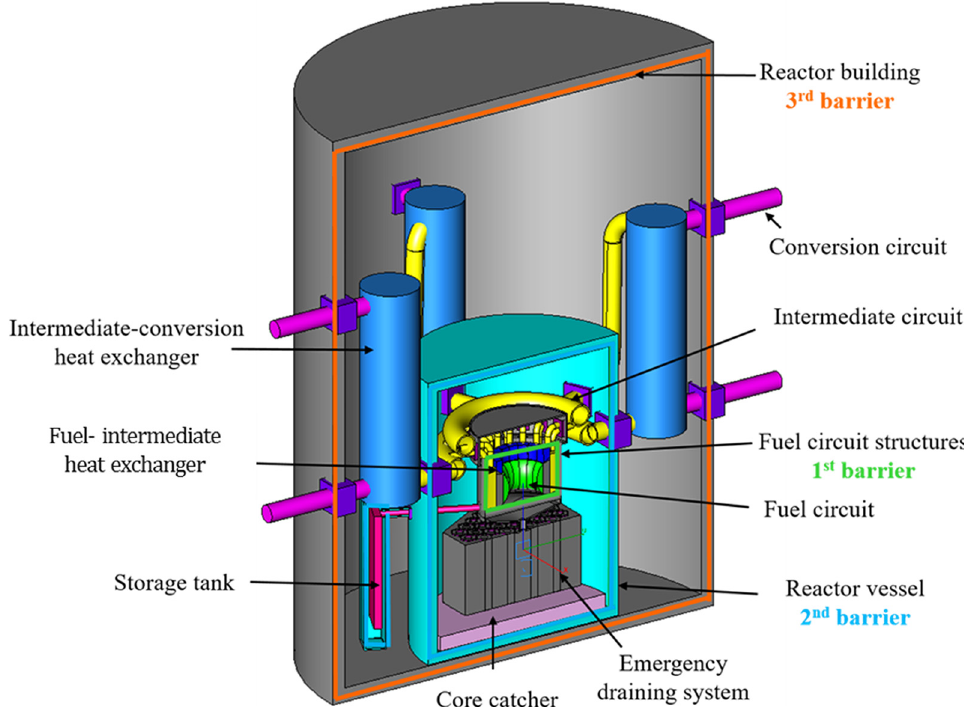
Fig. 2. Schematic view of the main systems located in the reactor building; proposals for the con fi nement barriers are